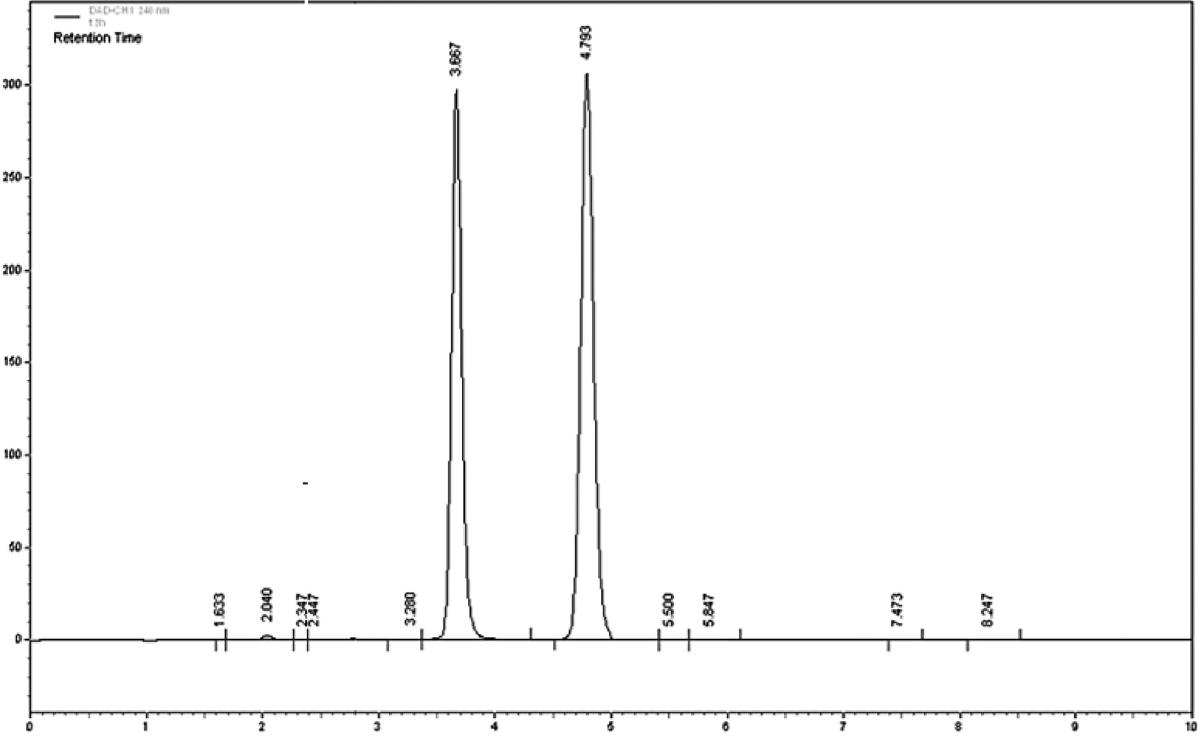
Figure 2: Chromatogram of 100 μ g/mL azacitidine after heat stressed conditions (37 ° C, 4